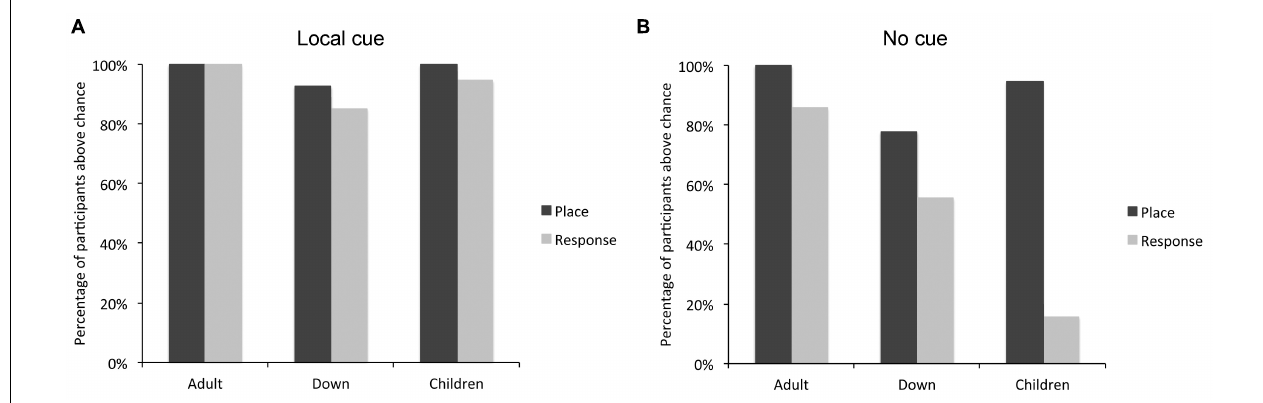
FIGURE 3 | Percentage of individuals with DS ( n = 27), TD children ( n = 19), and TD adults ( n = 21) who performed above chance level in the place learning and response learning tasks, in presence (A) or absence (B) of a local cue marking the reward